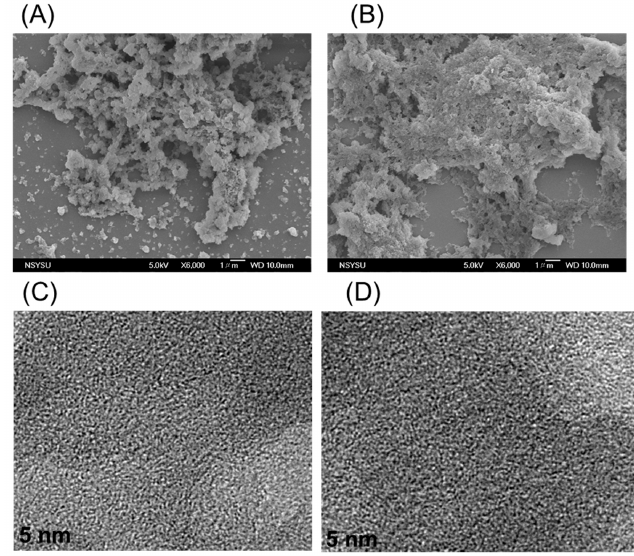
Figure 6. SEM images of ( A ) TPE-HPP and ( B ) DPT-HPP. TEM images of ( C ) TPE-HPP and ( D ) DPT- HPP.